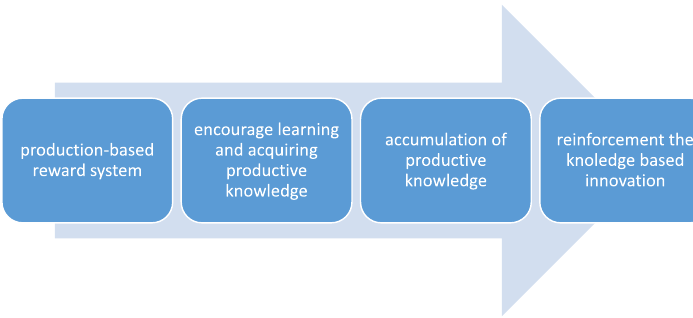
Fig. 2 Self-reinforcing mechanism of knowledge (innovation) based